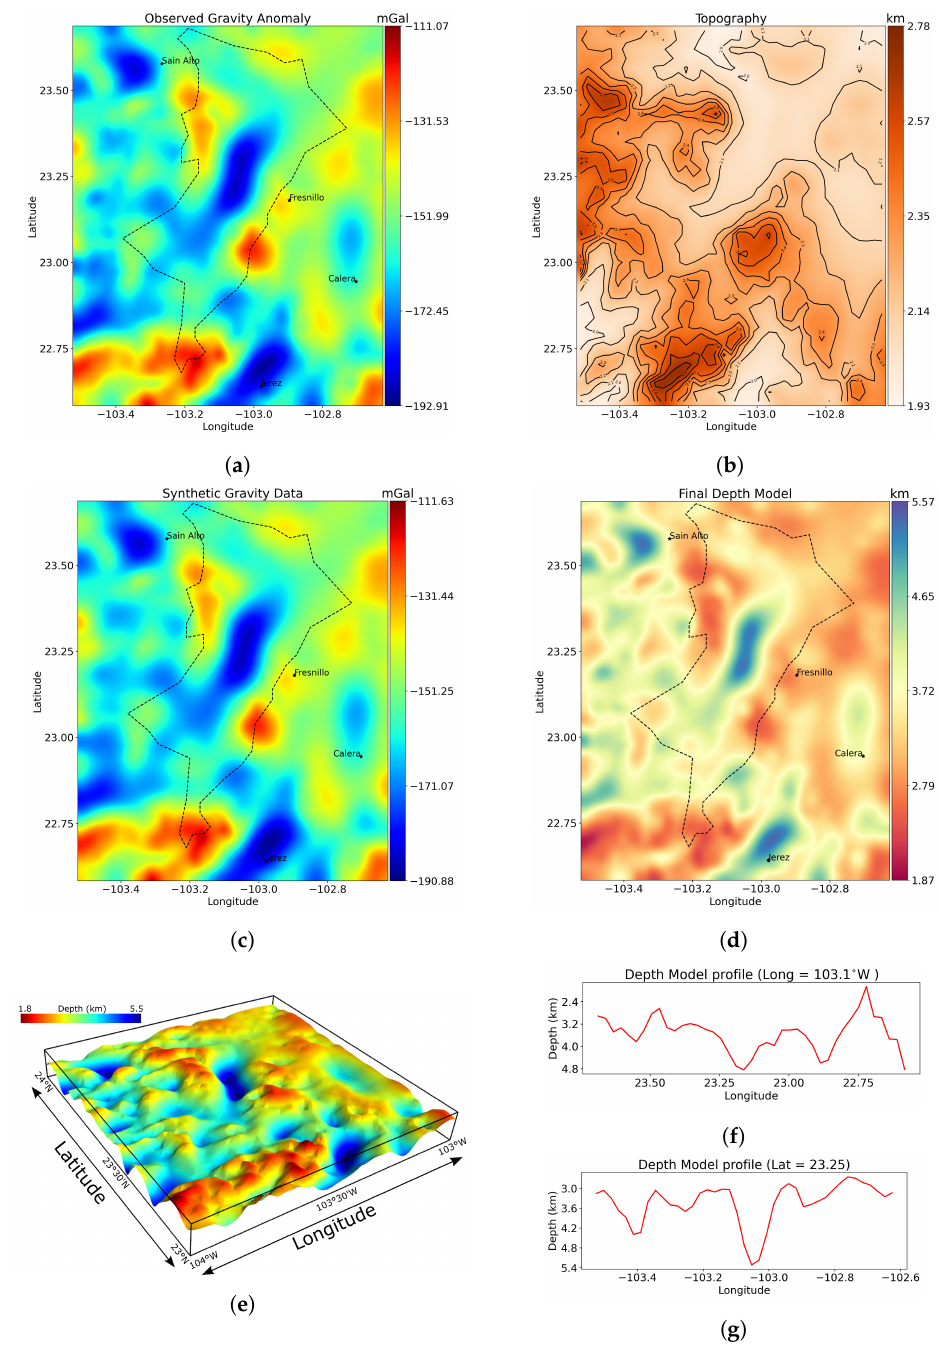
Figure 6. Observed gravimetric-satellite data for the area of interest ( a ) and its topography ( b ). The synthetic data after 10 iterations of CGLS method ( c ) recovers the observed data, obtaining the final depth model of ( d ). A 3D view of the basement (kilometers) is shown in ( e ). 1D profiles were picked for interpretation for N-S orientation at longitude 103 ◦ W ( f ) and for W-O orientation at latitude 23.25 ◦ N ( g